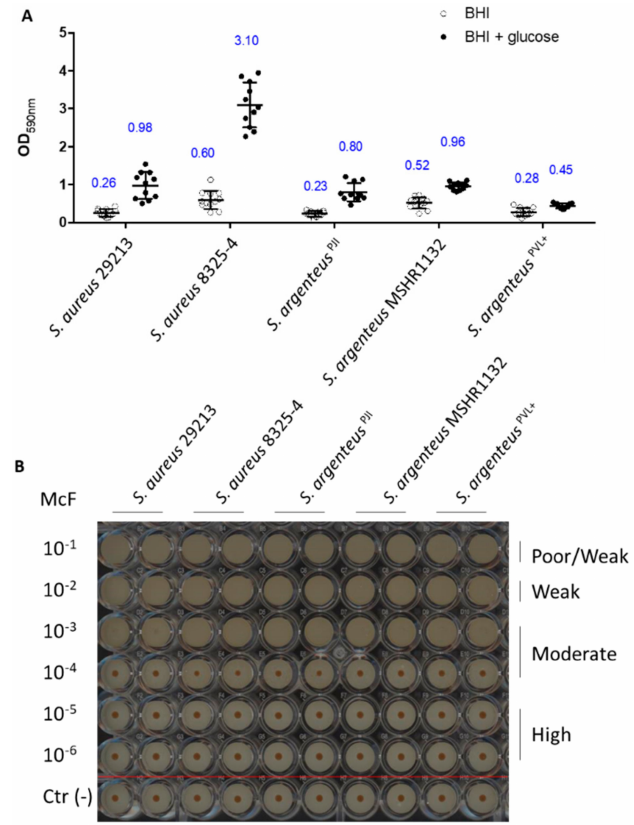
Figure 6. Biofilm formation capacities of the strains. ( A ) The biofilm formation after 24 h has been measured using OD measurement at 590 nm of the crystal violet staining (blue numbers are the OD 590 values). ( B ) The early production of biofilm was assessed using the BioFilm Ring Test ® technology and classified based on the previously published procedure [26]. The image is representative of three independent experiments. Negative controls were performed for each condition (below the red